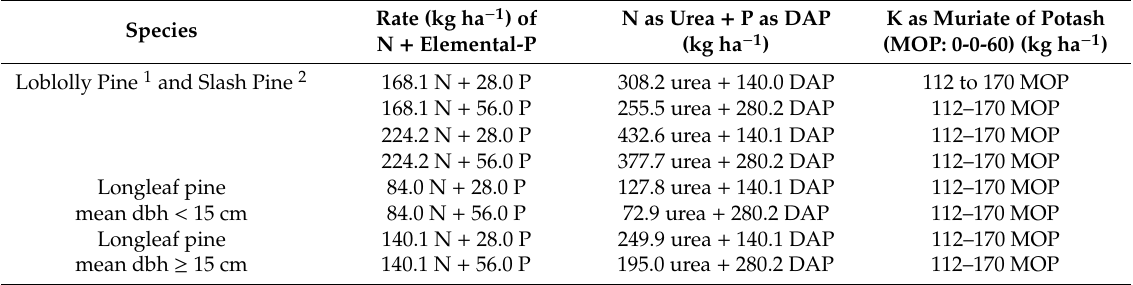
Table 9. Fertilizer application rates for loblolly, longleaf and slash pine at or after canopy closure using common fertilizer forms based on Table 2 N and P